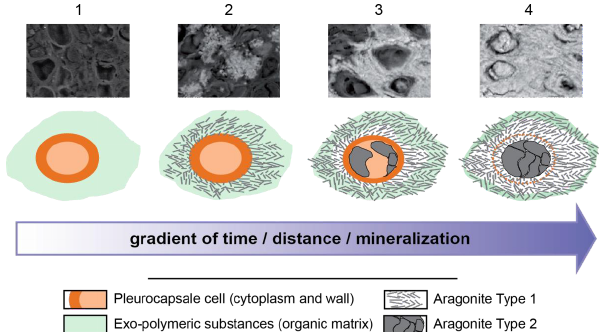
Figure 5. Summarizing sketch of Pleurocapsales encrustation within aragonite. Each step is illustrated by a SEM picture. The mineralization gradient increases from left to right. (1) Living colony of Pleurocapsales. (2) Needles of Type 1 aragonite nucleate and grow from the surface of Pleurocapsales cells. (3) Growth of Type 1 aragonite fills the space surrounding the cell and accommodates the transition from one encrusted cell to another. The inner part is still organic and starts to be replaced by Type 2 aragonite. (4) In the end, the cell is totally filled by aragonite; an organic wall separating Type 1 from Type 2 aragonite is preserved temporarily.